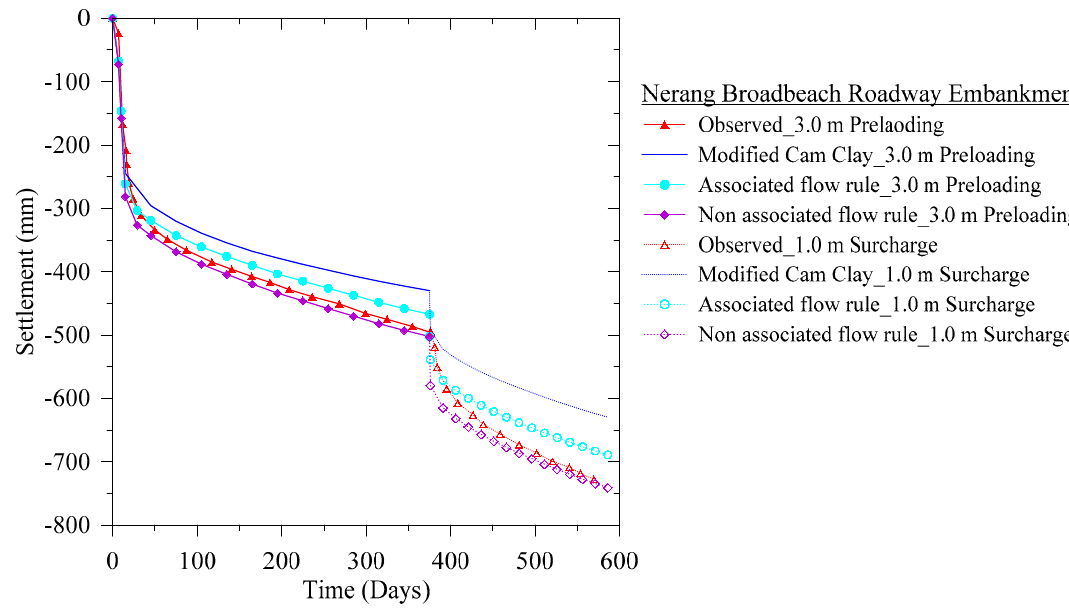
Figure 14. Comparison of observed and predicted settlement response of the Nerang Broadbeach